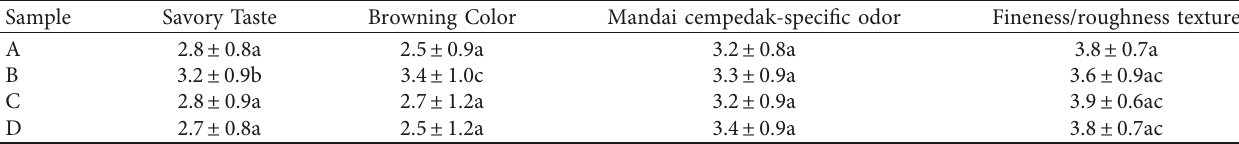
Table 4: Results of hedonic quality